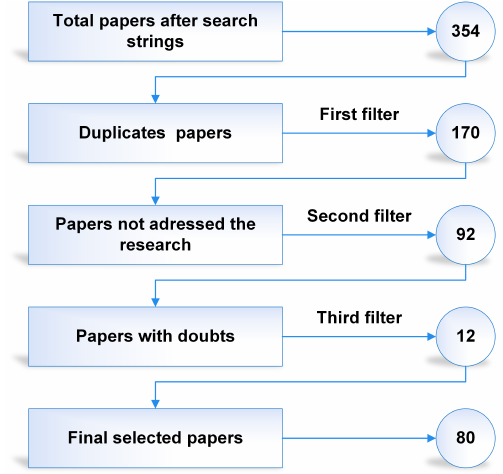
Figure 3. Filtering process to obtain final studies for